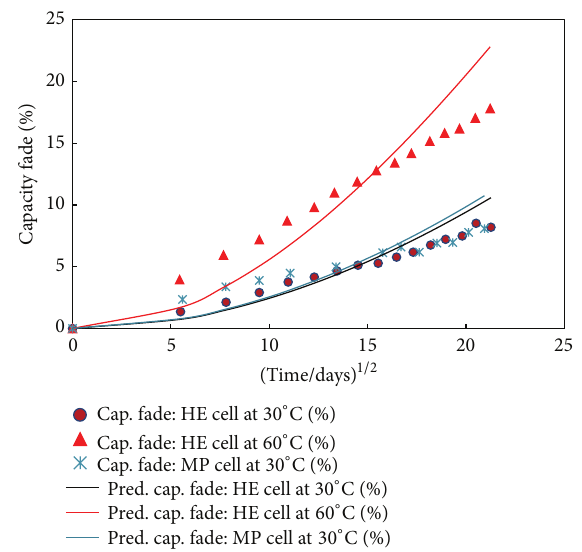
Figure 10: Percentage capacity loss versus time for HE type cells (at 30 ∘ C and 60 ∘ C) and MP type cells (at 30 ∘ C).